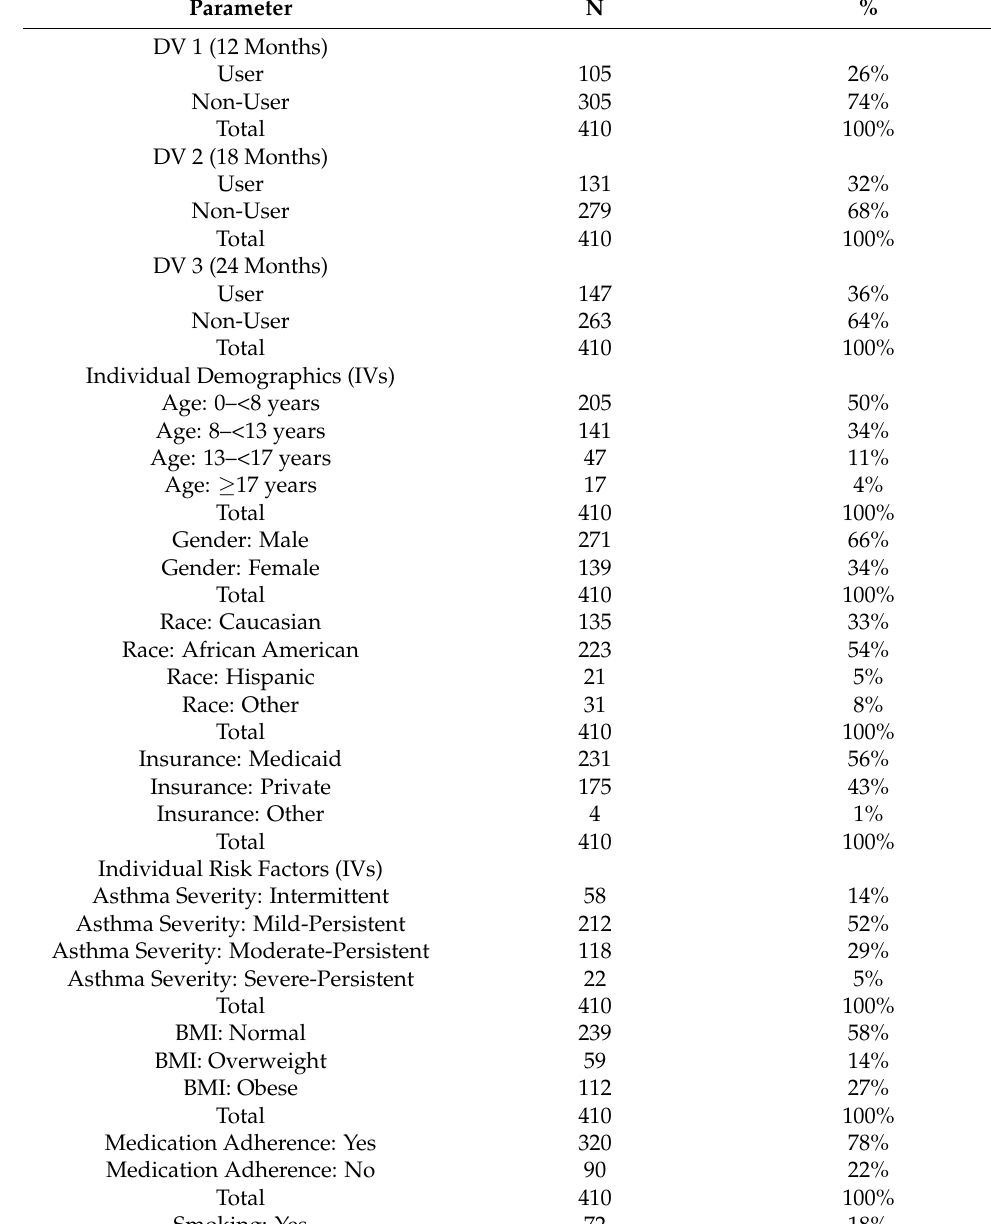
Table 1. Summary data on study